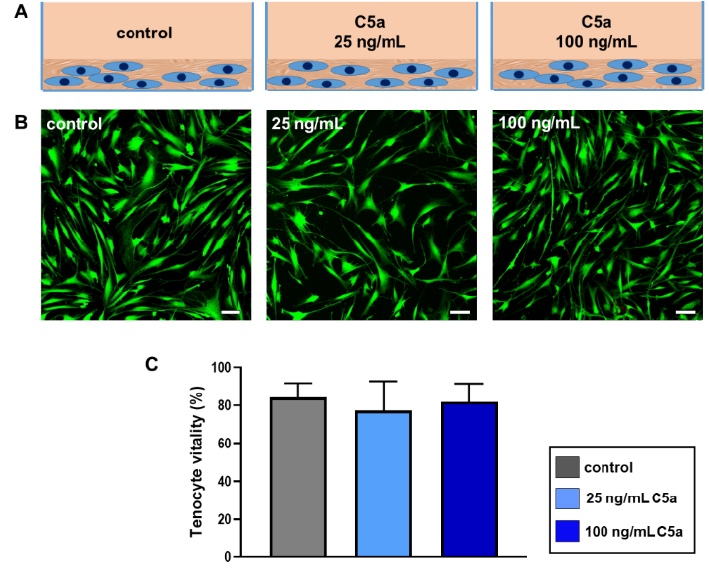
Figure 2. Schematic figure of the experimental setup ( A ). Tenocytes were stimulated with two concentrations (25 ng/mL and 100 ng/mL) of the recombinant protein anaphylatoxin C5a or remained unstimulated (control) for 24 h. ( B ) Representative images of live-dead staining of the tenocytes after 24 h stimulation with recombinant protein anaphylatoxin C5a. Fluorescein diacetate (green: vital cells) and propidium iodide (red: dead cells) have been used for staining. Scale bar = 100 µm. ( C ) Graphic presentation of tenocytes vitality after 24 h stimulation with 25 ng/mL (light blue) and 100 ng/mL (dark blue) recombinant C5a protein in comparison to the non-stimulated control groups (grey). Number of living cells in relation to total cells (100%) measured in live-dead staining images of the tenocytes. Mean values and the standard errors of mean (SEM) are depicted. Shapiro–Wilk test was used to test the normal distribution of data. One sample t -test was performed in relation to the theoretical mean of 100%. n = 3 independent experiments were performed using tenocytes derived from three different donors.